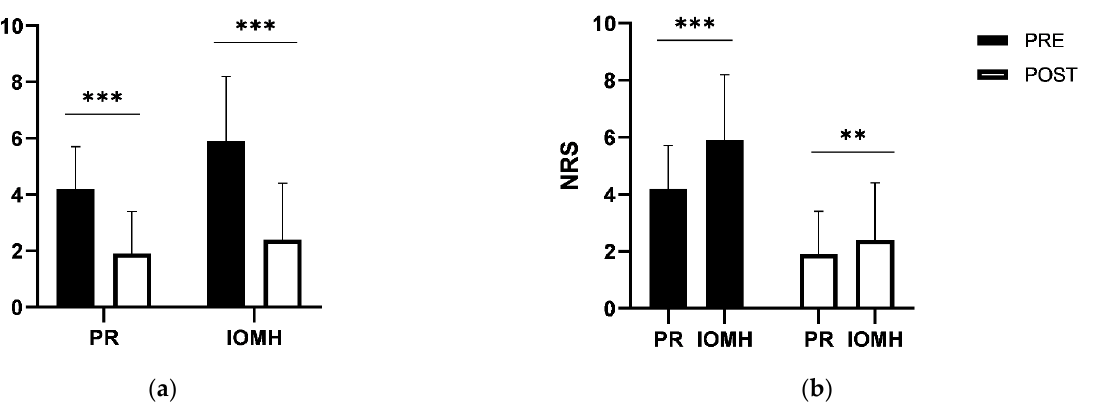
Figure 3. Overview of subjective evaluation of clinical results (in %).